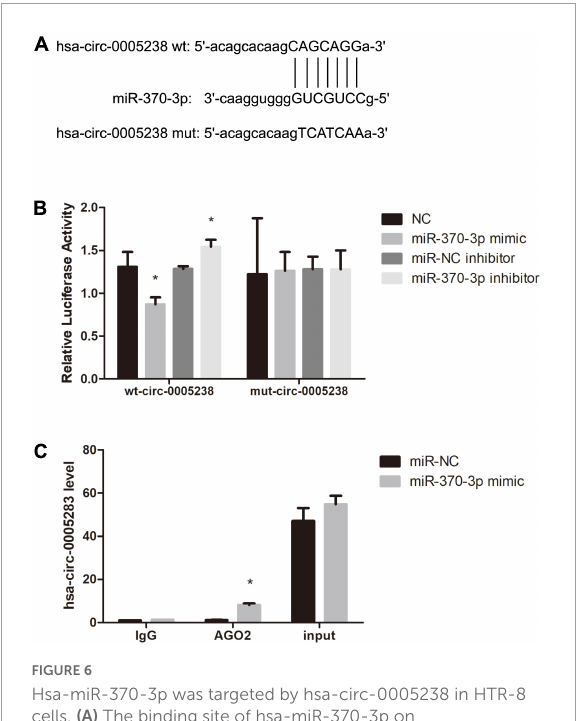
FIGURE6 Hsa-miR-370-3p was targeted by hsa-circ-0005238 in HTR-8 cells. (A) The binding site of hsa-miR-370-3p on hsa-circ-0005238. (B) Results of the dual luciferase activity assay. (C) Results of the anti-AGO2 immunoprecipitation (RIP) assay. * P <